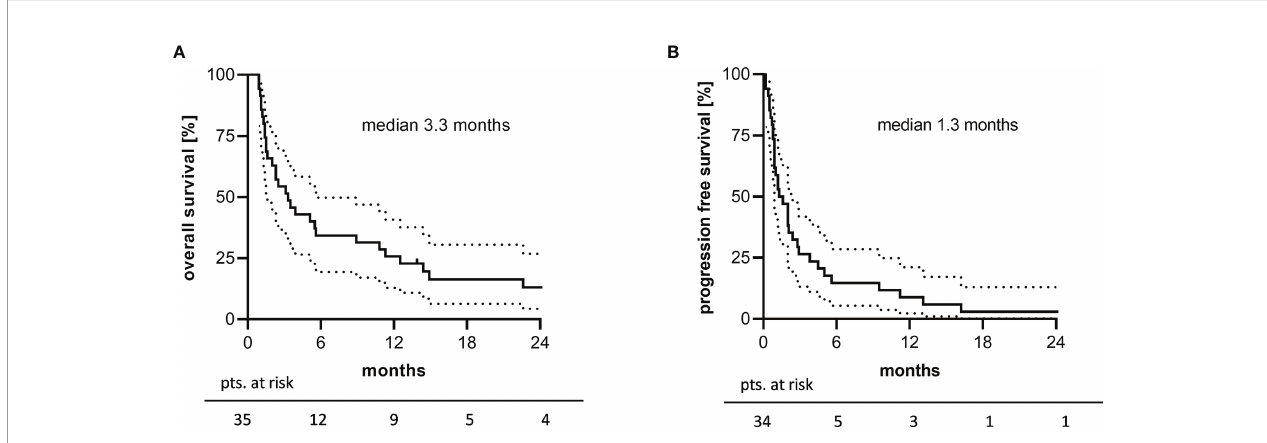
FIGURE 2 | 2-years survival analysis of the study cohort. Kaplan-Meier plots of (A) overall survival and (B) progression free survival are depicted. Unavailable PFS data in one patient explain the difference in patients at risk. The dotted line represents the 95% con fi dence